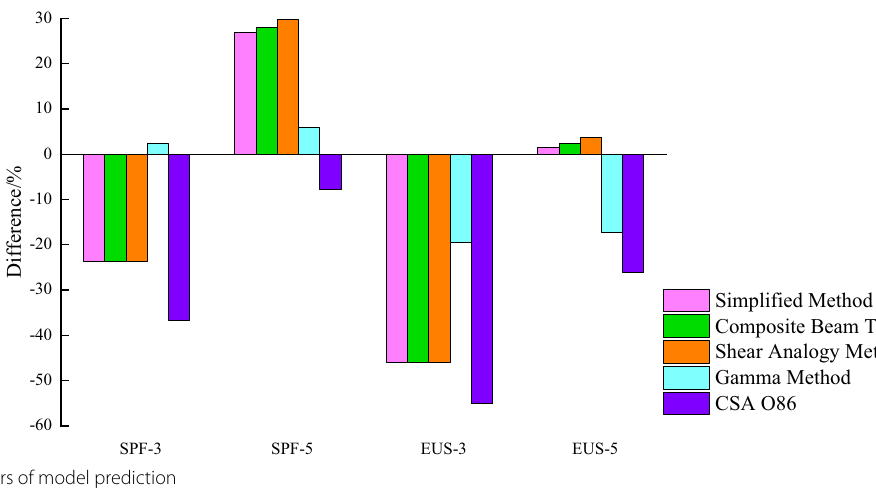
Fig. 9 The errors of model prediction